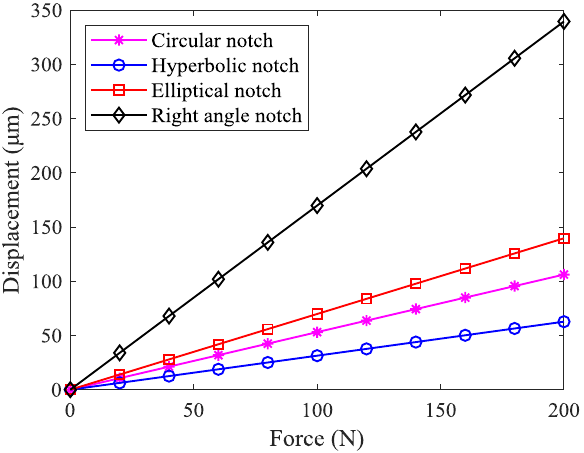
Figure 3. Force-displacement relationship of four common flexure hinges.